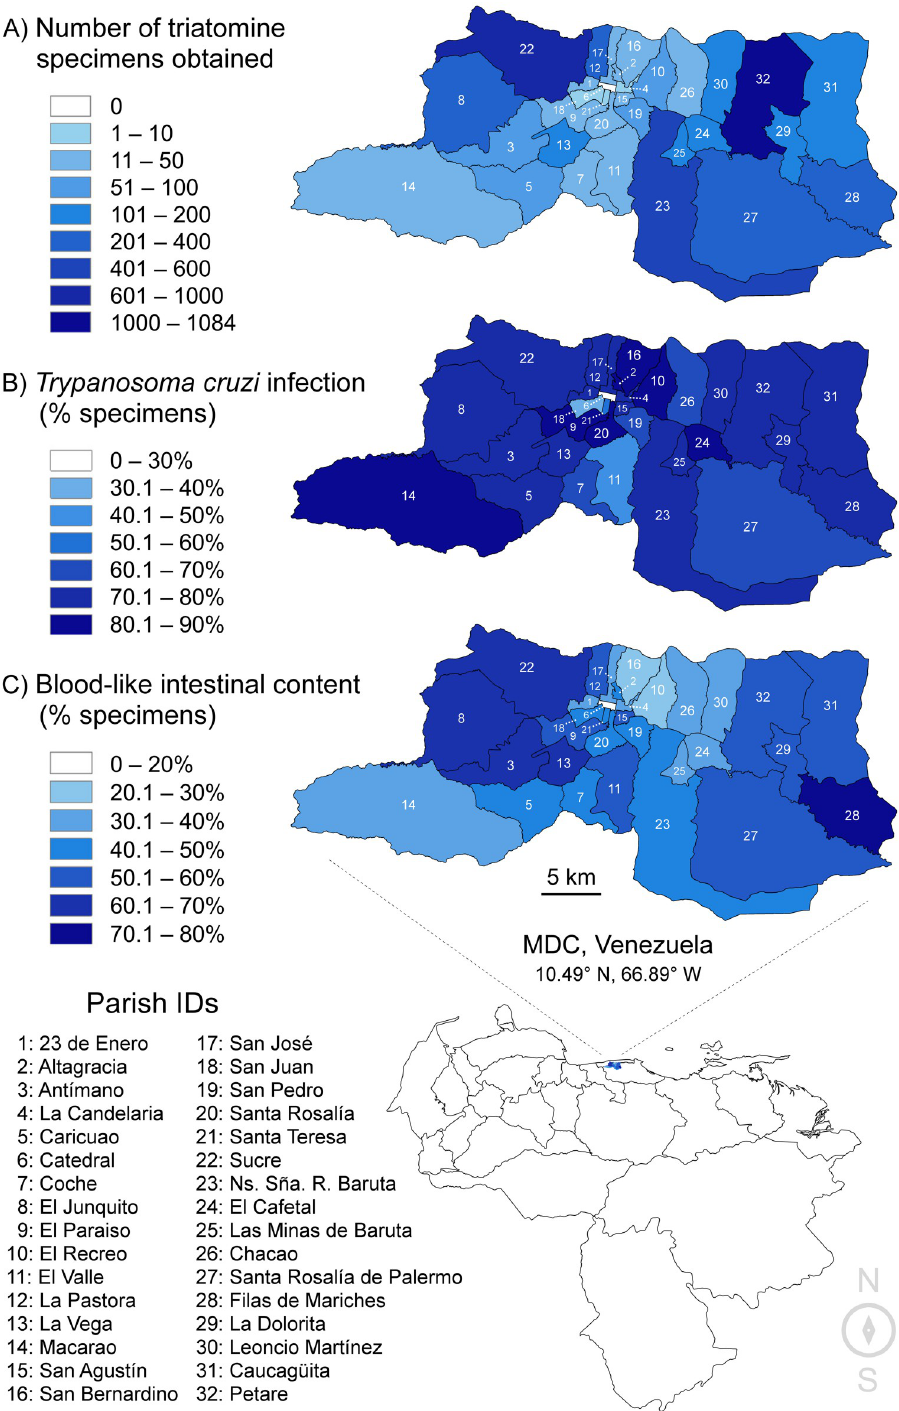
Fig 1. A. Numbers of triatomine specimens obtained from each MDC parish for the collection period 2007–2019. Fill color in the choropleth map represents the total number of specimens obtained per parish, increasing from lighter to darker blues. No specimens were obtained from Catedral parish (#6, white fill). A total of 4872 specimens were obtained across 31 parishes. B. Rates of natural T . cruzi infection in triatomine specimens from each MDC parish for the collection period 2007–2019. Fill color in the choropleth map represents the rate of T . cruzi infection (by microscopy) per parish, increasing from lighter to darker blues. Infection occurred in all parishes from